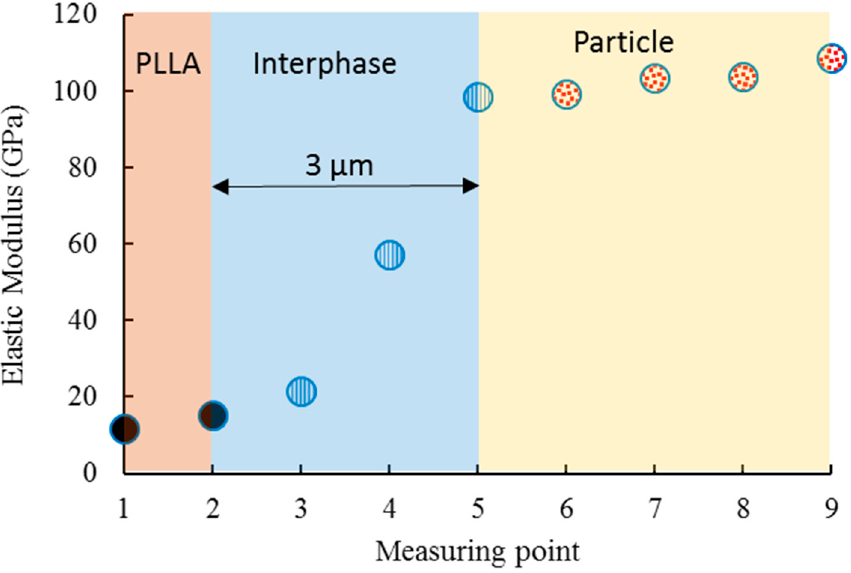
Figure 5. Nanoindentation response at a region close to the particle’s edge.